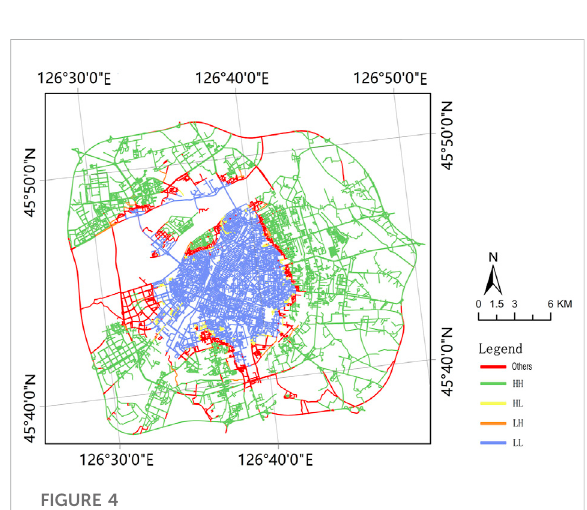
FIGURE 4 Spatial autocorrelation of road network in Harbin ’ s